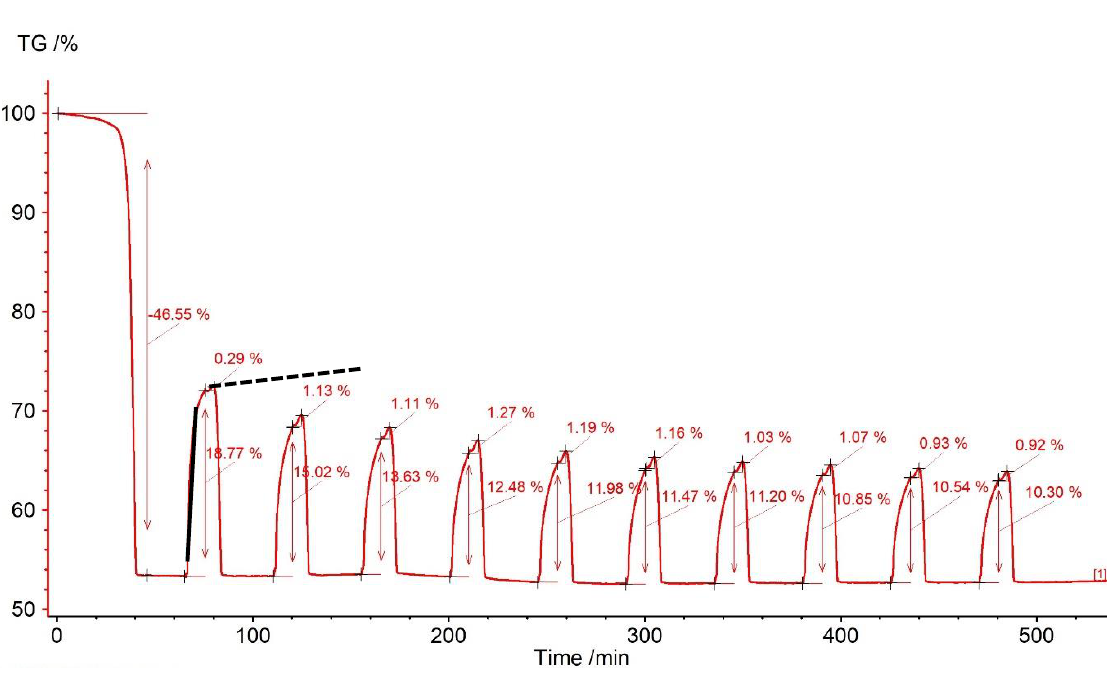
Figure 5. Relative mass changes for dolomite in the CaL process (the solid black line marks the section of the surface reaction, and the dashed line marks the section possibly corresponding to diffusion).